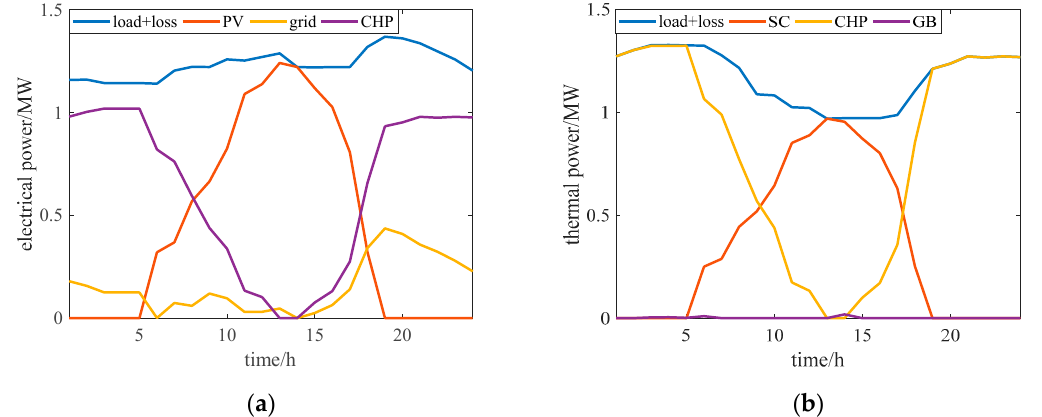
Figure 7. ( a ) Electrical power output in Case 2.2; ( b ) thermal power output in Case 2.2.